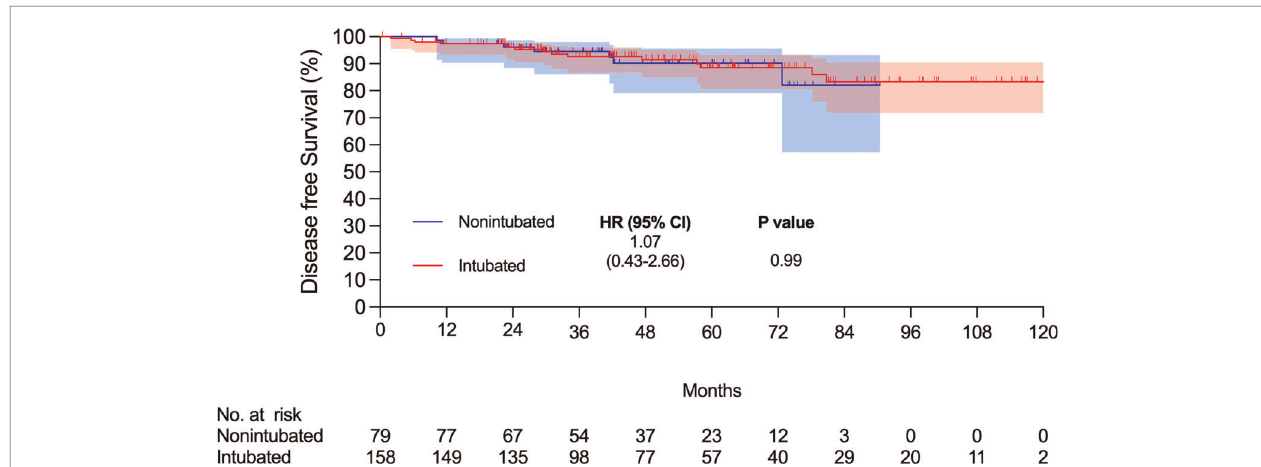
FIGURE 2 | Kaplan – Meier overall survival curve. Abbreviations: CI, con fi dence interval; HR, hazard ratio.